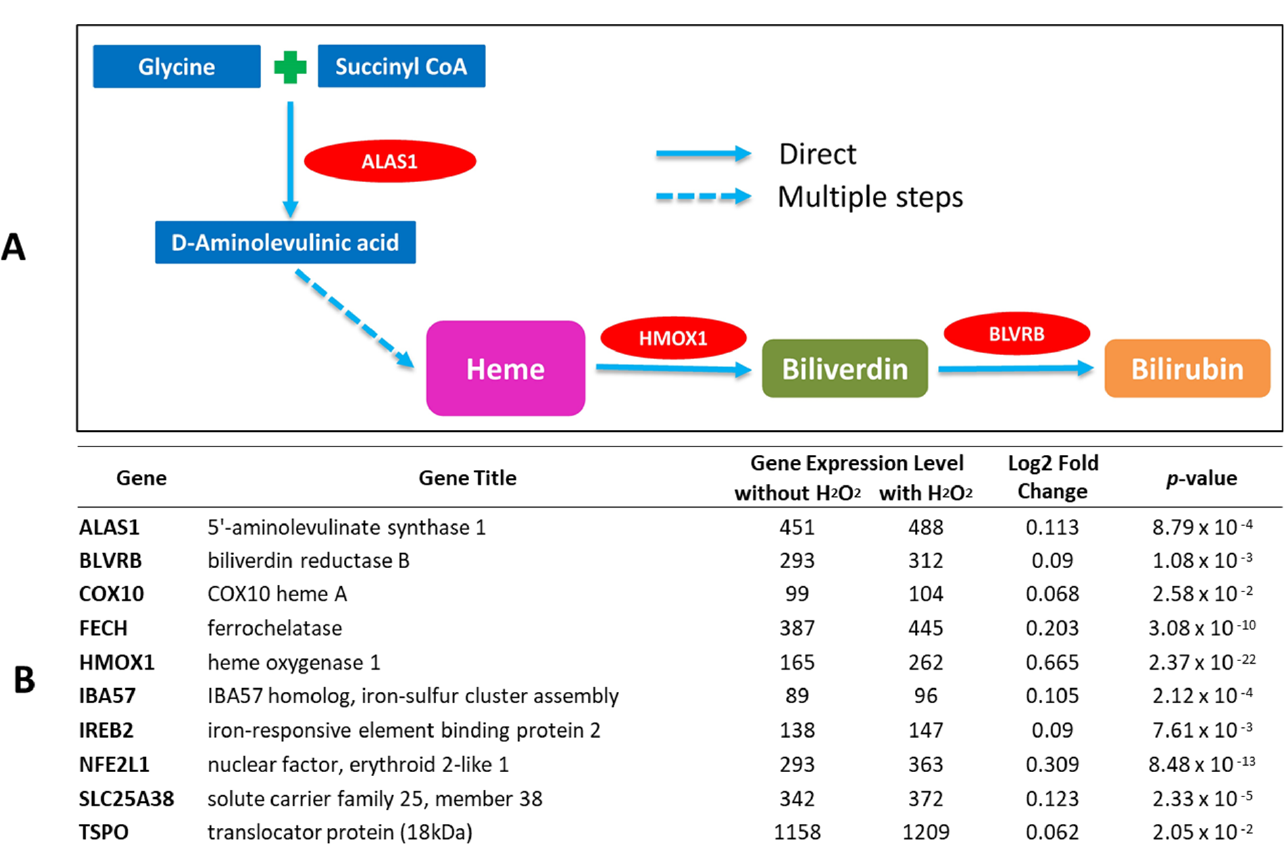
Figure 1. Transcriptome expression of key genes involved in heme and bilirubin synthesis detected from tKC cell culture with and without hydrogen peroxide treatment. ( A ) Simplified diagram of heme biosynthesis and bilirubin production ( B ) List of key genes with transcriptome expression level, log2 fold changes, and p -values of hydrogen peroxide treatment group vs. no treatment control group. Genes encoding key enzymes ( ALAS1 , HMOX1 , and BLVRB) were all significantly upregulated by hydrogen peroxide treatment (250 µ M, 6 h). n =